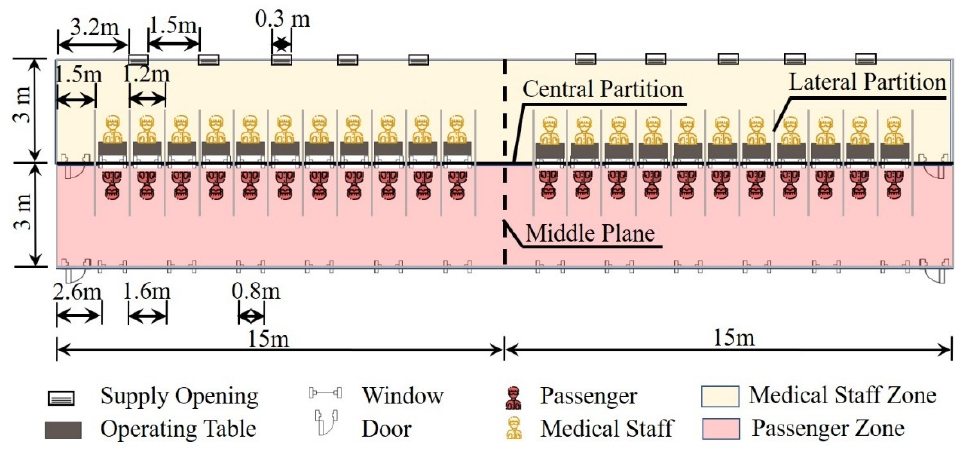
Figure 1. Plan view of a sampling cabin.